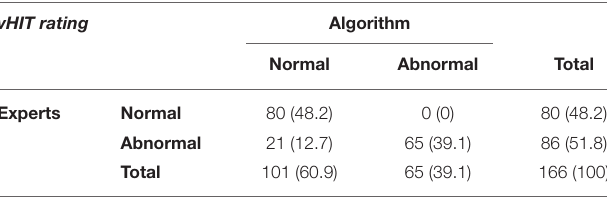
TABLE 1 | Cross table of the algorithm’s (VOR gain cutoff at 0.7) and experts’ judgements on the vHITs of 166 patients with AVS.